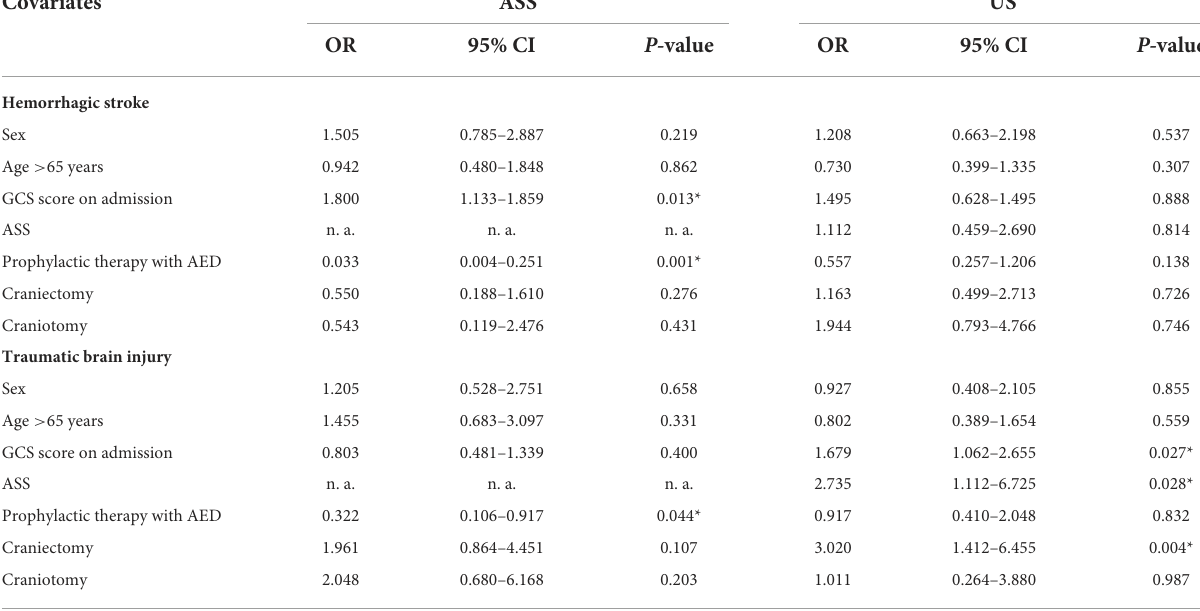
TABLE 3 Potential risk factors for seizures occurrence in patients with acquired brain injury divided by type of injury. Covariates